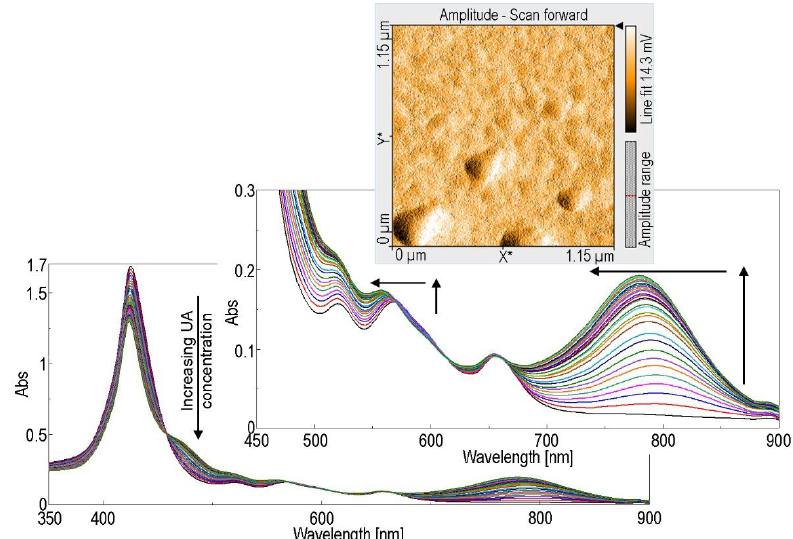
Figure 20. Overlapped UV-Vis spectra of complex TAmPP-PtNPs after continuous adding of uric acid. In detail AFM image of the material after treatment with uric acid.